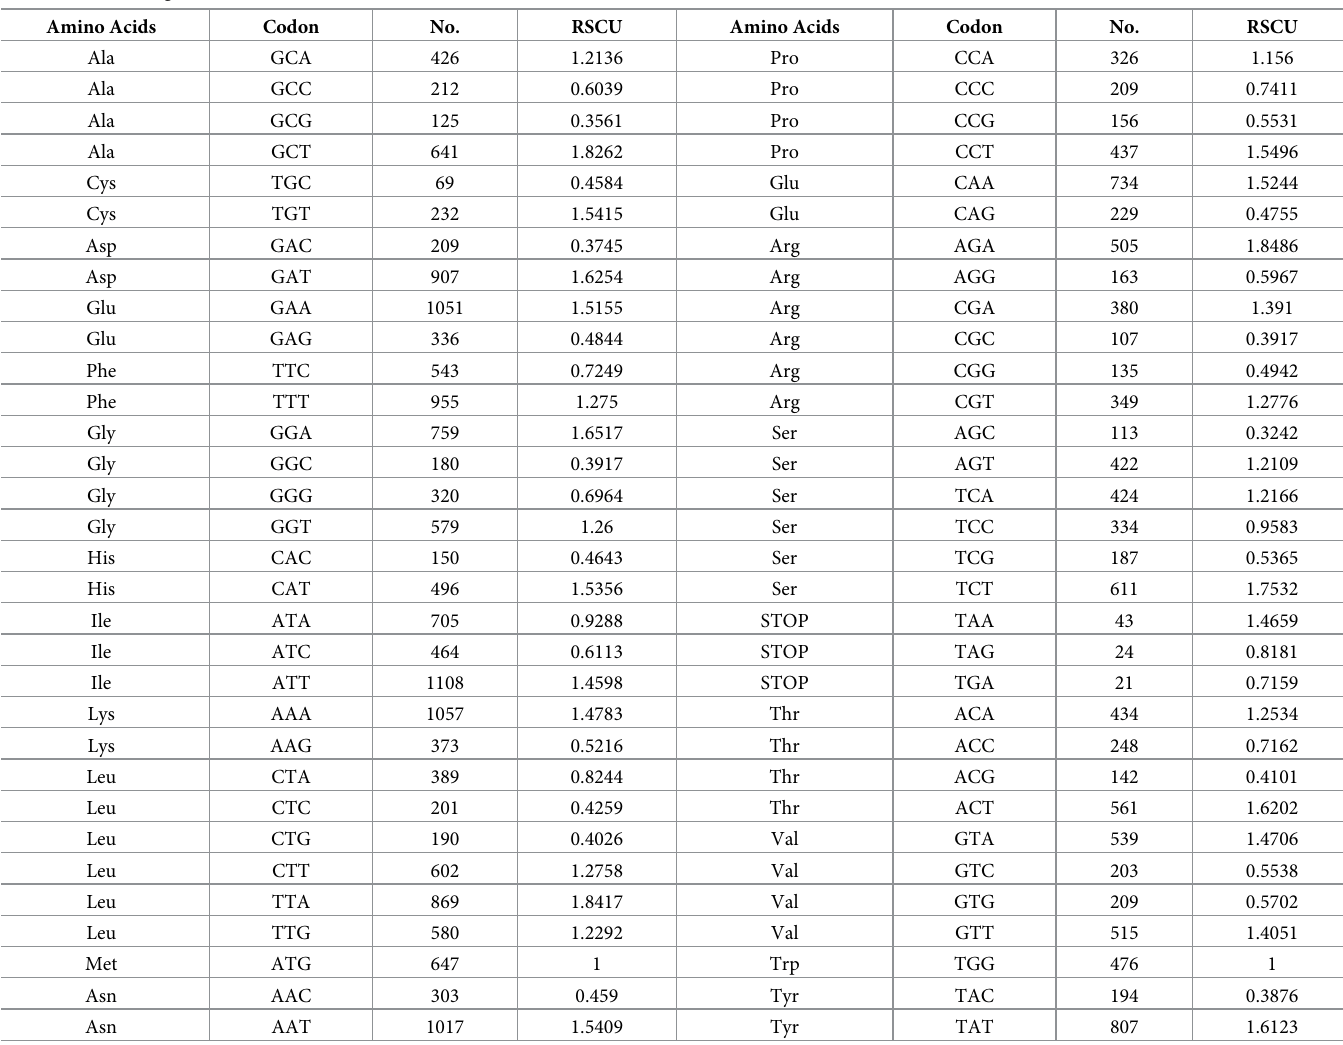
Table 3. Codon usage in I . dabieshanensis